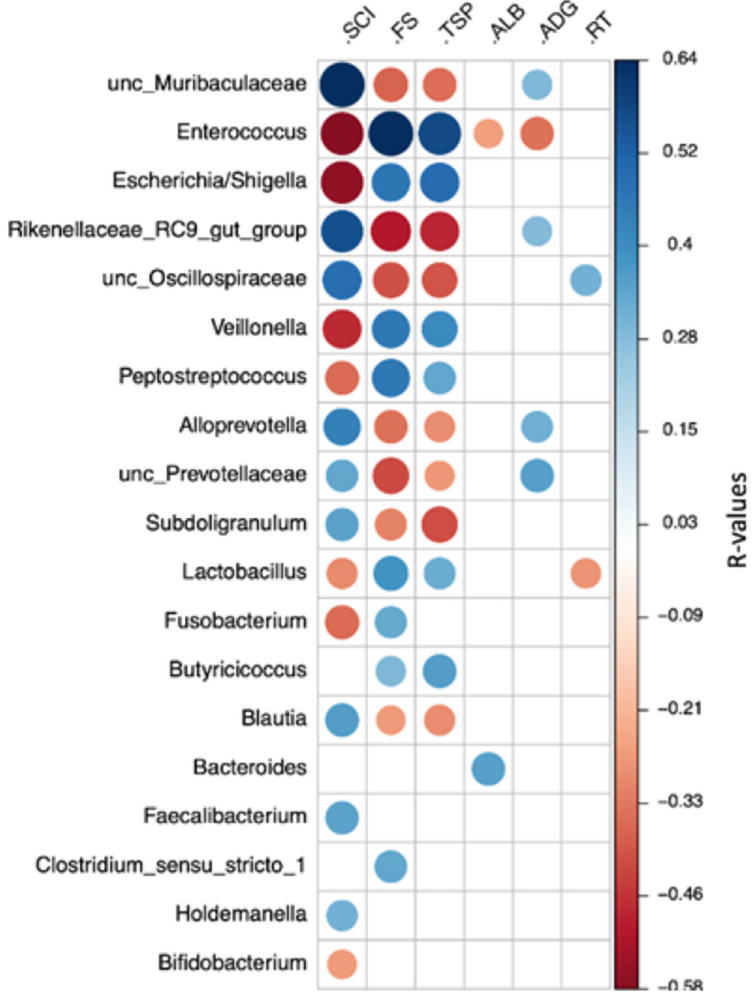
Fig 8. Heatmap showing the Spearman’s rank correlation coefficients and statistical significance between genera abundance and calves’ parameters. Blue and red colors indicate significant positive and negative correlations, respectively ( P < 0.05). SCI, starter concentrate intake; FS, fecal score; TSP, total serum protein; ALB, albumin; ADG, average daily gain; RT, rectal